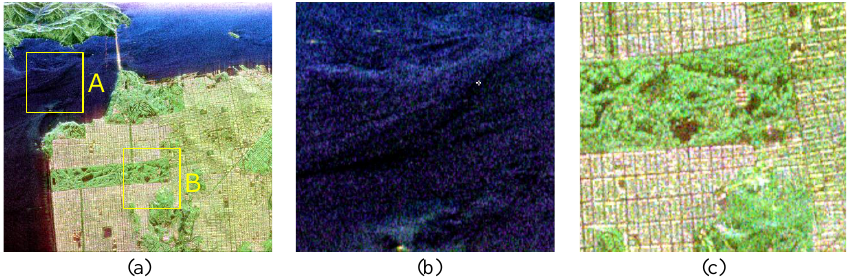
Figure 2. An example of an AIRSAR L-Band PolSAR image. ( a ) The AIRSAR L-Band PolSAR image. ( b ) Enlarged region A. ( c ) Enlarged region B.